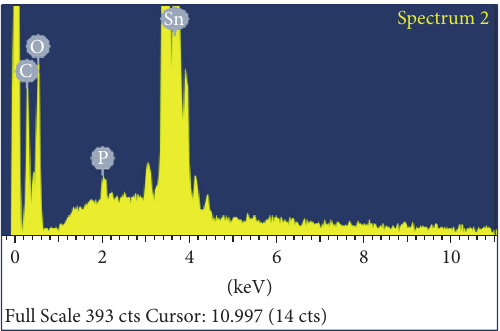
Figure 2: EDX spectrum of SnO 2 @ phenyl-phosphonic acid (S1).